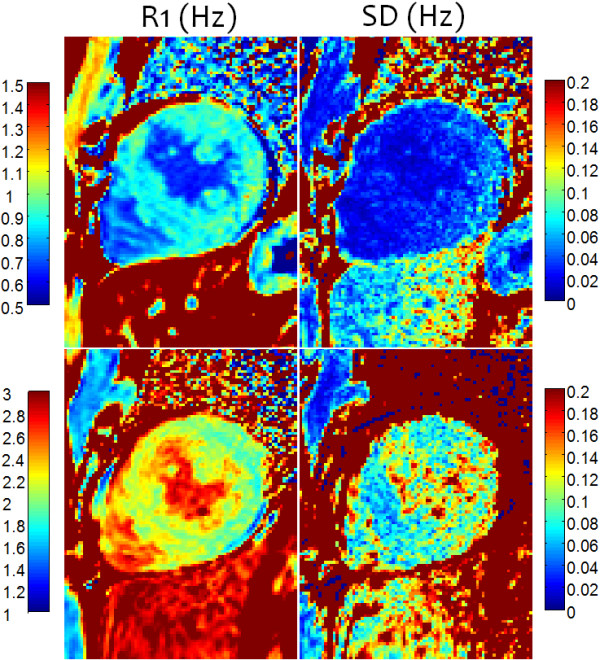
R1 and SD maps for subject with HCM acquired pre-contrast (TOP) and post-contrast (BOTTOM), corresponding to the T1-maps shown in Figure
9
.